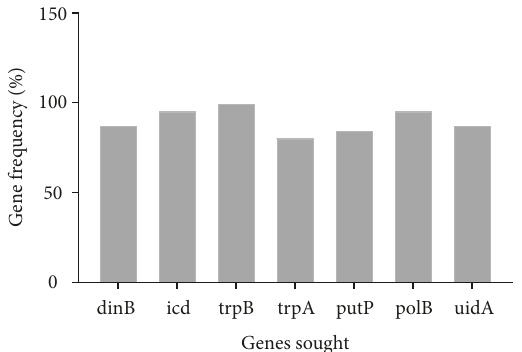
Figure 3: Percentage of E. coli household genes